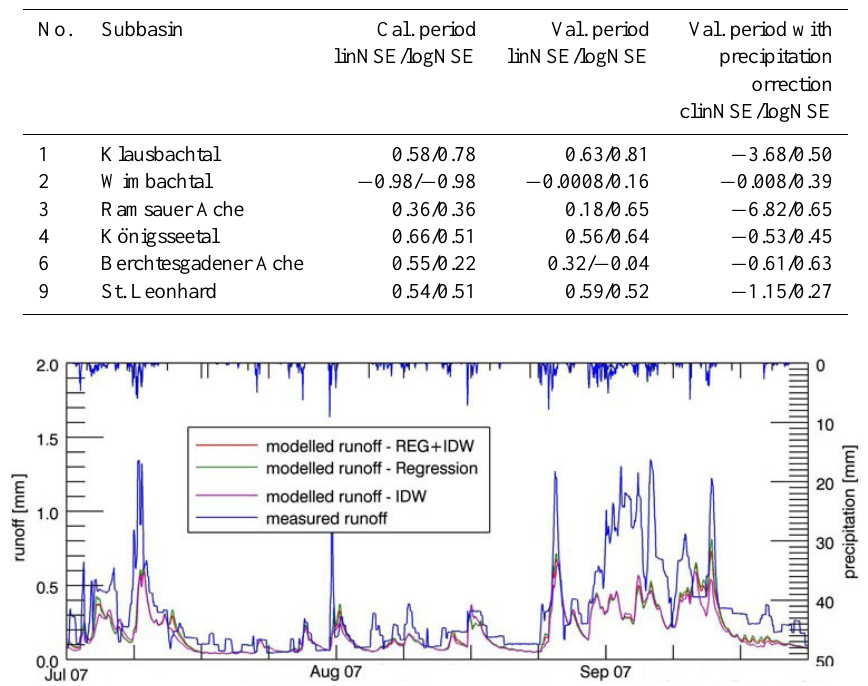
Table 3. Nash Sutcliffe efficiency (NSE) in the calibration period, validation period and validation period with precipitation correction for several subbasins.